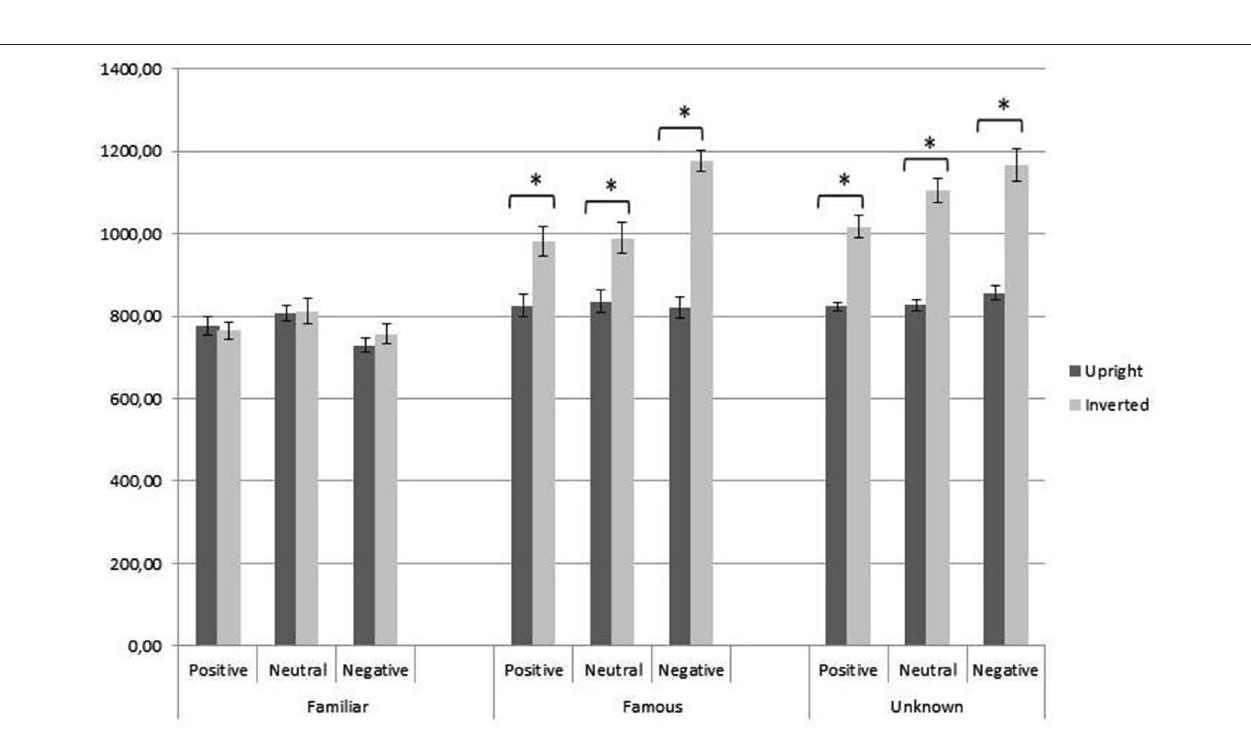
FIGURE 4 | Interaction between orientation, class and expression comparing for orientation . Single asterisk indicates significance at p <